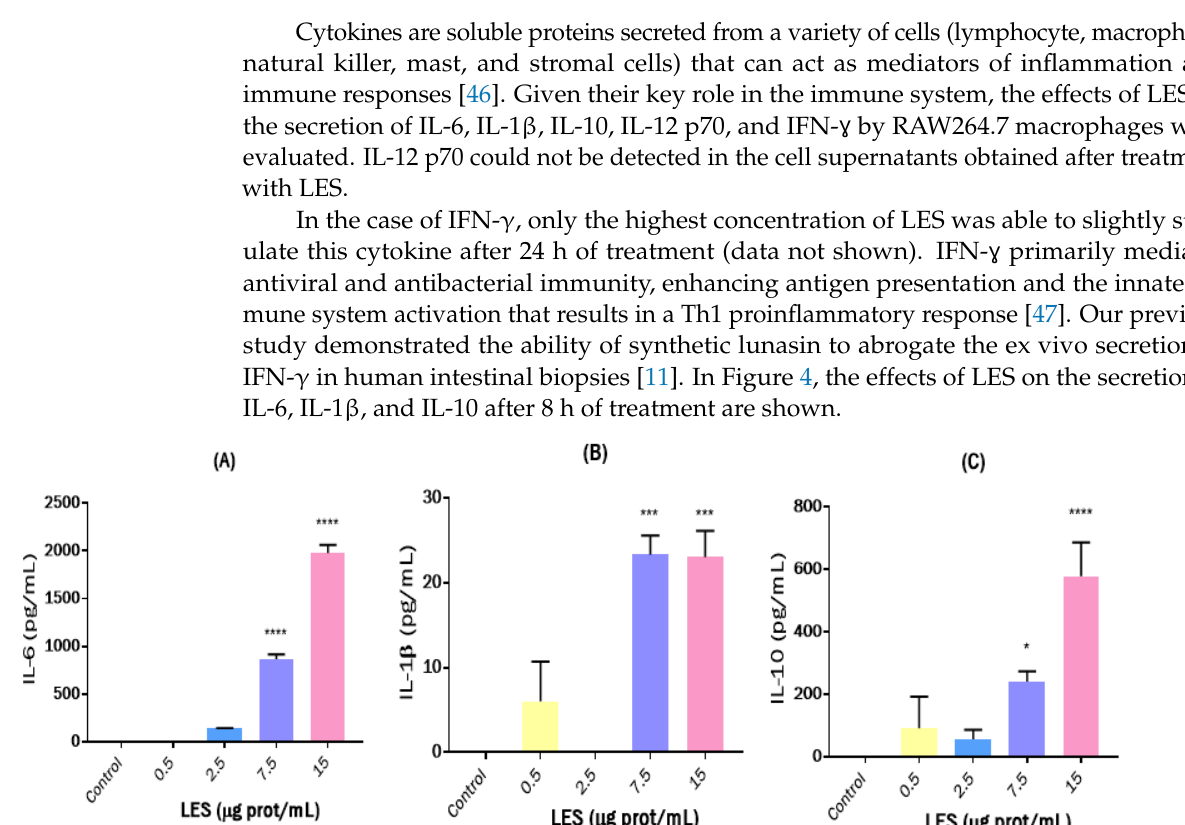
Figure 4. Effects of lunasin-enriched soybean extract (LES) on cytokine release by RAW264.7 macrophages. Effects of LES (0.5–15 µ g protein/mL) on the release of ( A ) IL-6, ( B ) IL-1 β , and ( C ) IL-10 after 8 h of treatment. Significant differences compared to control: * p < 0.05; *** p < 0.001; **** p < 0.0001. LES also showed a dose-dependent stimulatory effect on IL- 1β secretion at the three times assayed, reaching values for this cytokine up to 23.04, 12.54, and 3.81 pg/mL after 8,